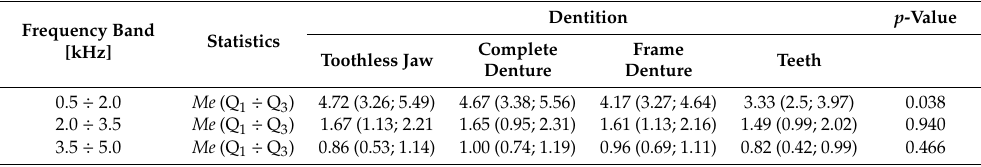
Table 4. Basic statistics of effective vibration velocity vRMS (mm/s) measured on the left and right side of 6 skulls in 1500-Hz frequency bands in different states of dentition. Kruskal–Wallis test results. Significant differences of at least p < 0.05 were noted.